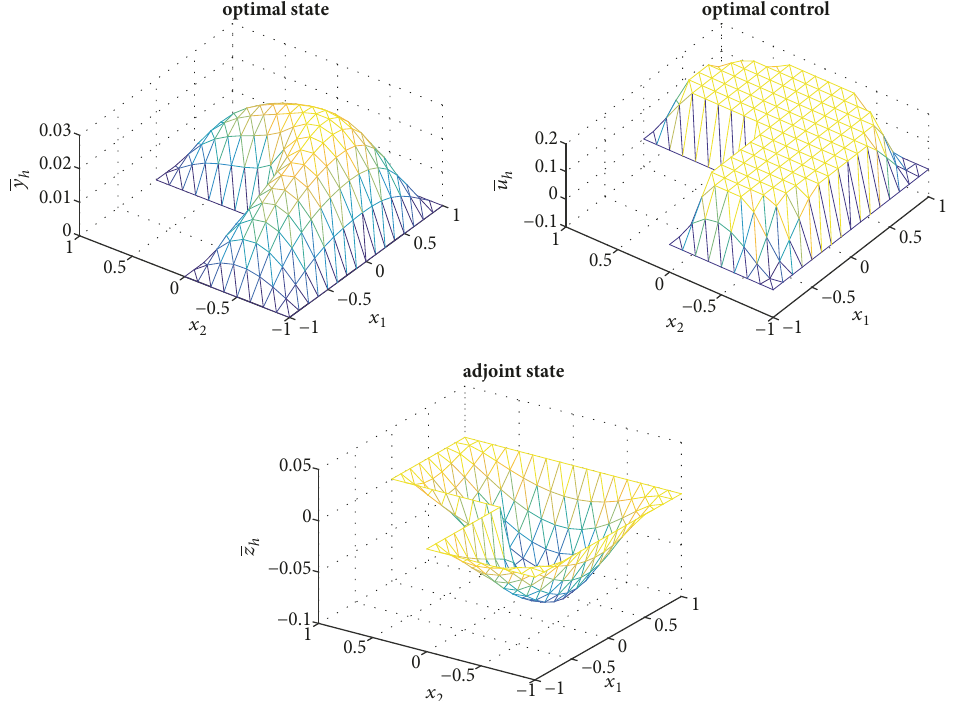
Figure 6: Numerical results of Experiment 3: optimal state, optimal control, and corresponding adjoint